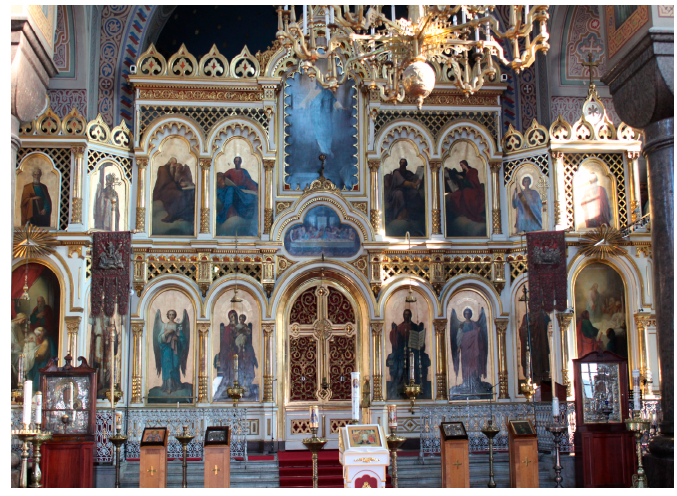
Figure 2. Church interior (iconostasis) in the Uspenski Cathedral in Helsinki. Photo by the author. During liturgies, they also face and contemplate icons of Mary, Jesus, and other saints. In their eyes, these figures do not belong to one single national realm, but rather transcend national borders.